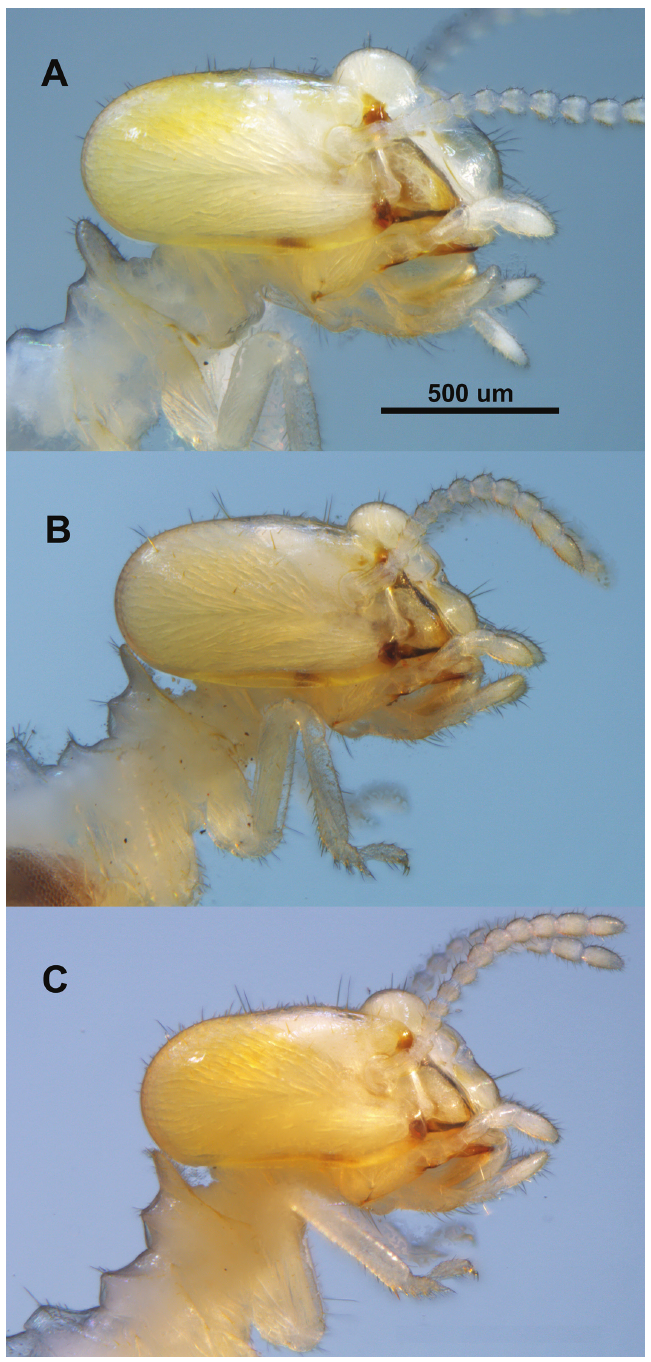
Figure 4. Parvitermes worker head and thorax, lateral views. A P. mexicanus comb. n. B P. mesoameri- canus sp. n. C P. yucatanus sp.